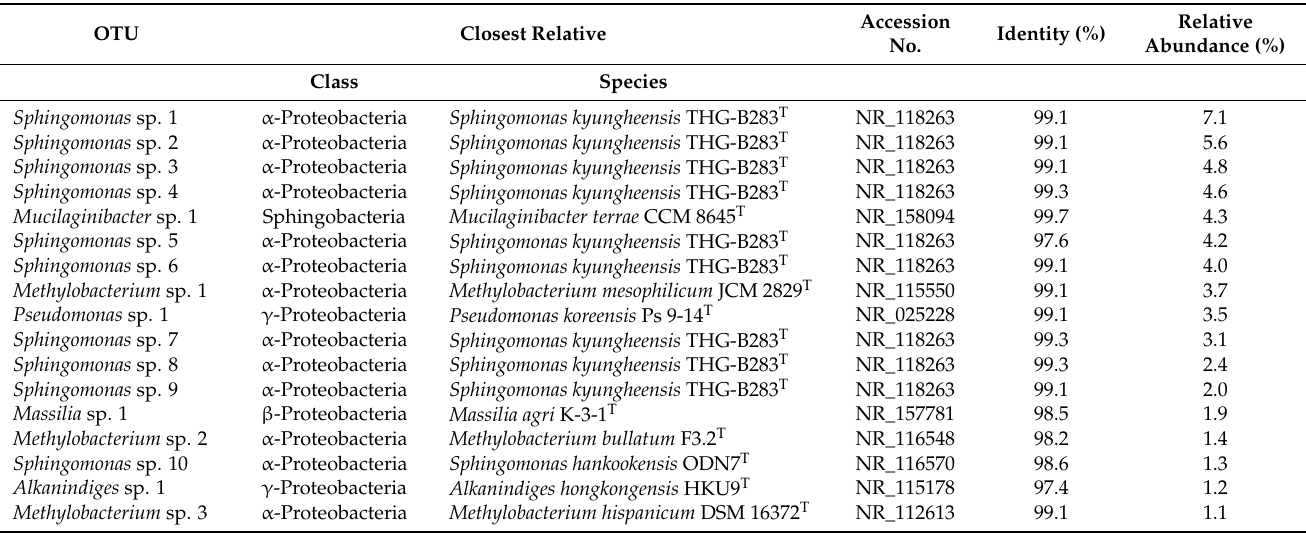
Figure 2. Consensus bootstrap phylogenetic tree constructed from analysis of the 16S rRNA gene sequences showing the relationships between OTUs comprising more than 1% and the related type strains. Each OTU is indicated as its representative type strain. The tree was rooted using Sulfurisphaera tokodaii 7 T as the outgroup. The bar indicates a 0.05% nucleotide substitution rate. Table 1. Bacteria with more than 1% of OTUs observed in the culture sample.